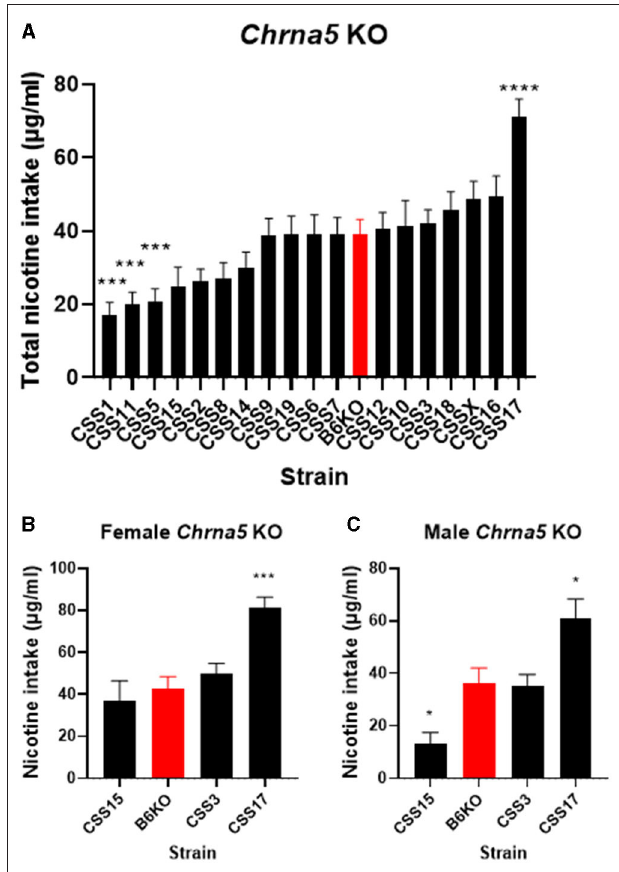
FIGURE 3 | Within Chrna5 KO genotype comparison of nicotine consumption between individual CSS Chrna5 KO and B6 Chrna5 KO mice (B6KO). (A) Shows total nicotine consumption for all strains collapsed on sex (A) . For those strains in which there was a main effect of sex, data are shown separately for female (B) and male (C) animals. * q < 0.05, *** q < 0.005, **** q < 5 × 10 − 5 for pairwise comparison of nicotine consumption between CSS Chrna 5KO and B6 Chrna 5KO . Data shown represent mean ± SEM. N = 9–16 per strain per sex.